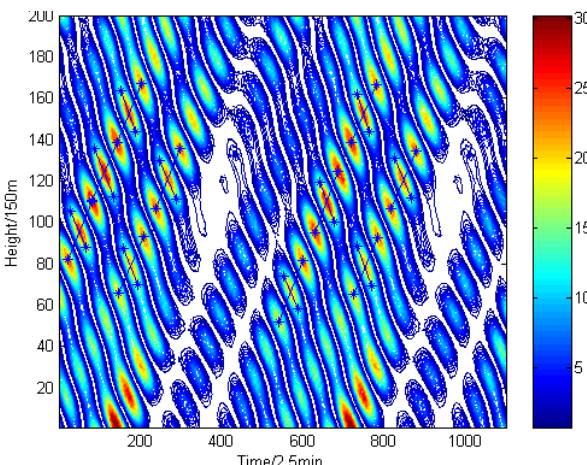
Fig. 7. A partial range-time plot of (δV ) 2 of zonal velocity con- Fig.7 A partial range-time plot of ( ) 2 V δ of zonal velocity converted from left panel of Fig.6a. verted from left panel of Fig. 6a. Determinations of vertical phase Determinations of vertical phase and group velocities of wave packets were indicated and group velocities of wave packets were indicated by the phase by the phase lines (along the patch) and energy lines (across the patch). 10 lines (along the patch) and energy lines (across the patch).